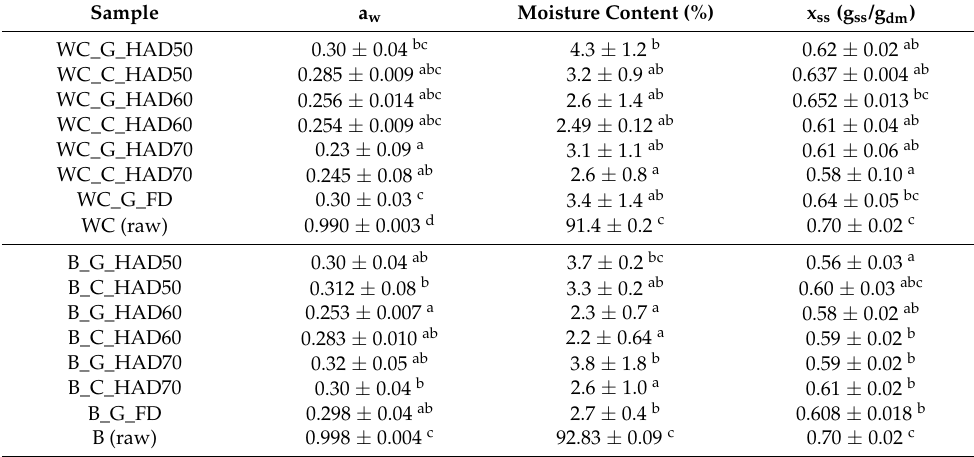
Table 1. Water activity (a w ), moisture content (g water/100 g) and soluble solids content (x ss in g soluble solids/g dry matter) of white cabbage (WC) and broccoli (B) samples. G: ground, C: chopped; HAD: hot-air drying at 50, 60 and 70 ◦ C, FD: freeze drying. Mean ± standard deviation of six